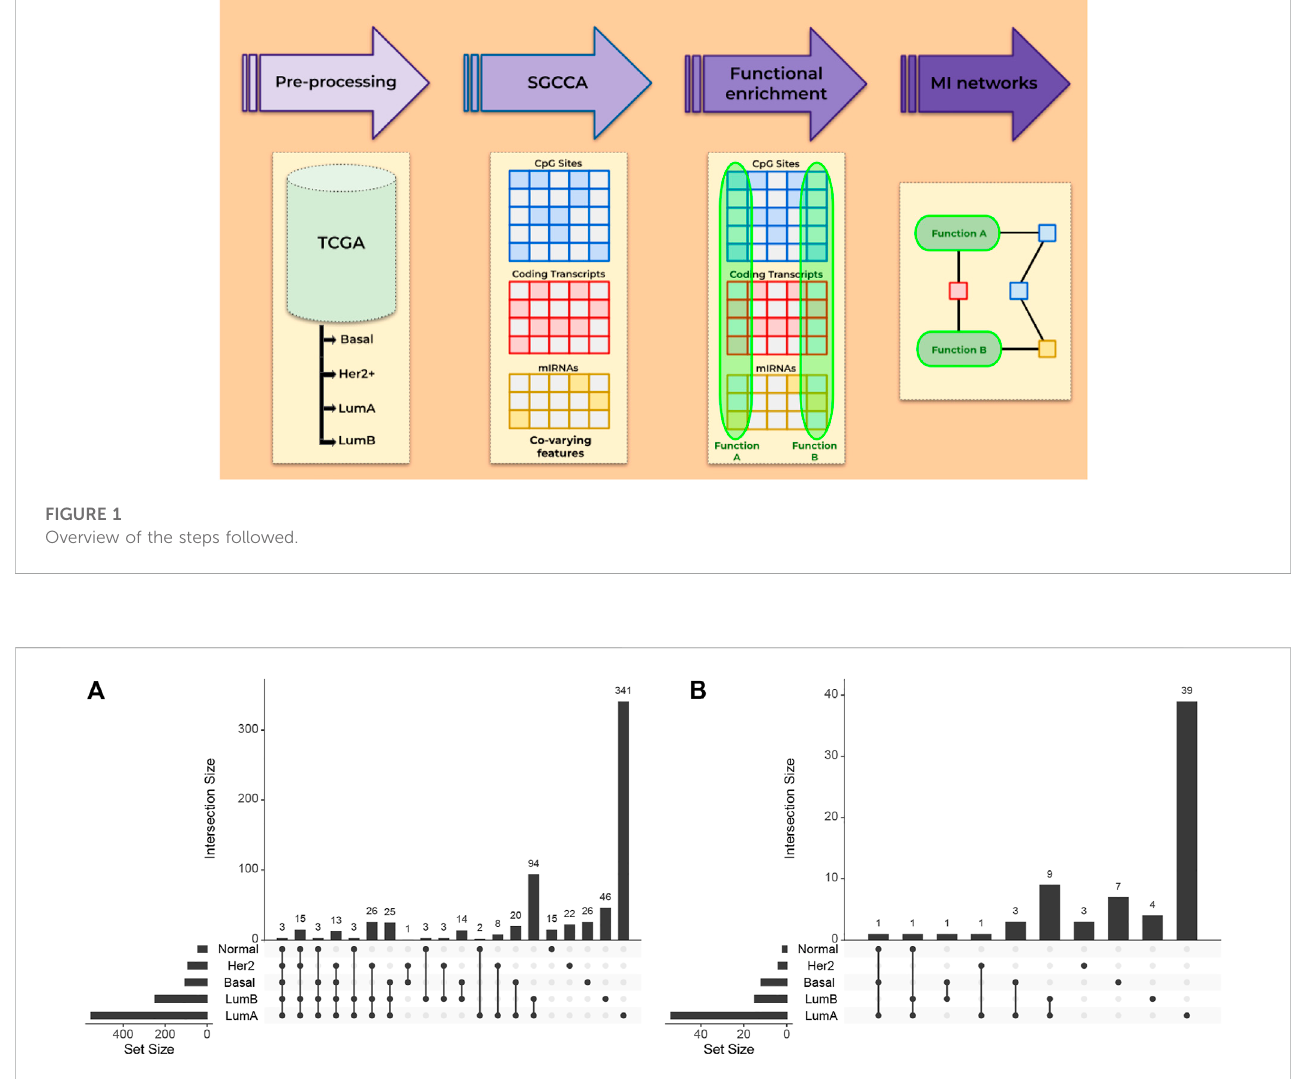
FIGURE 2 UpSet plot for (A) biological processes and (B) KEGG pathways